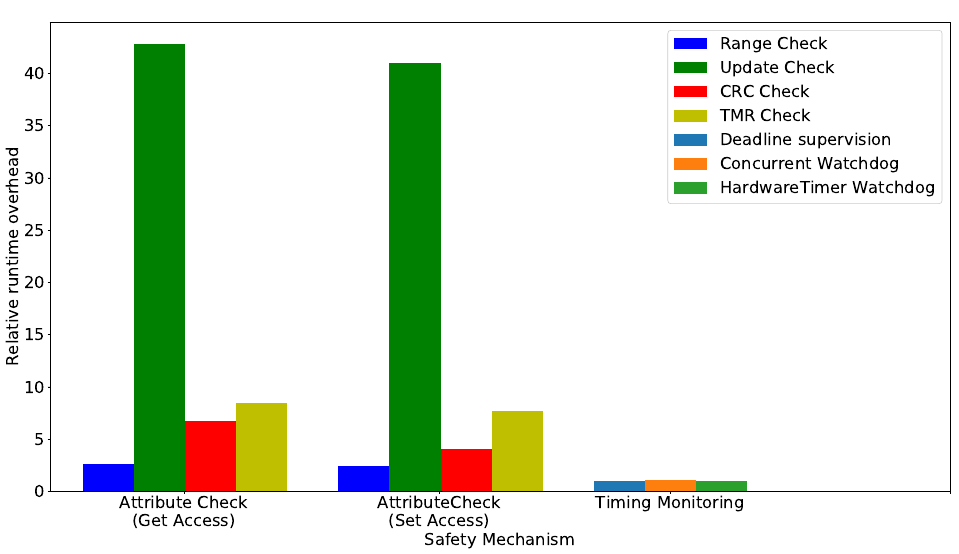
Figure 18. Relative runtime overhead for the error detection for attributes and timing constraint mon- itoring . A value of 1 is used as the baseline, i.e., no runtime overhead. A value of 2 means a 100% runtime overhead compared to the